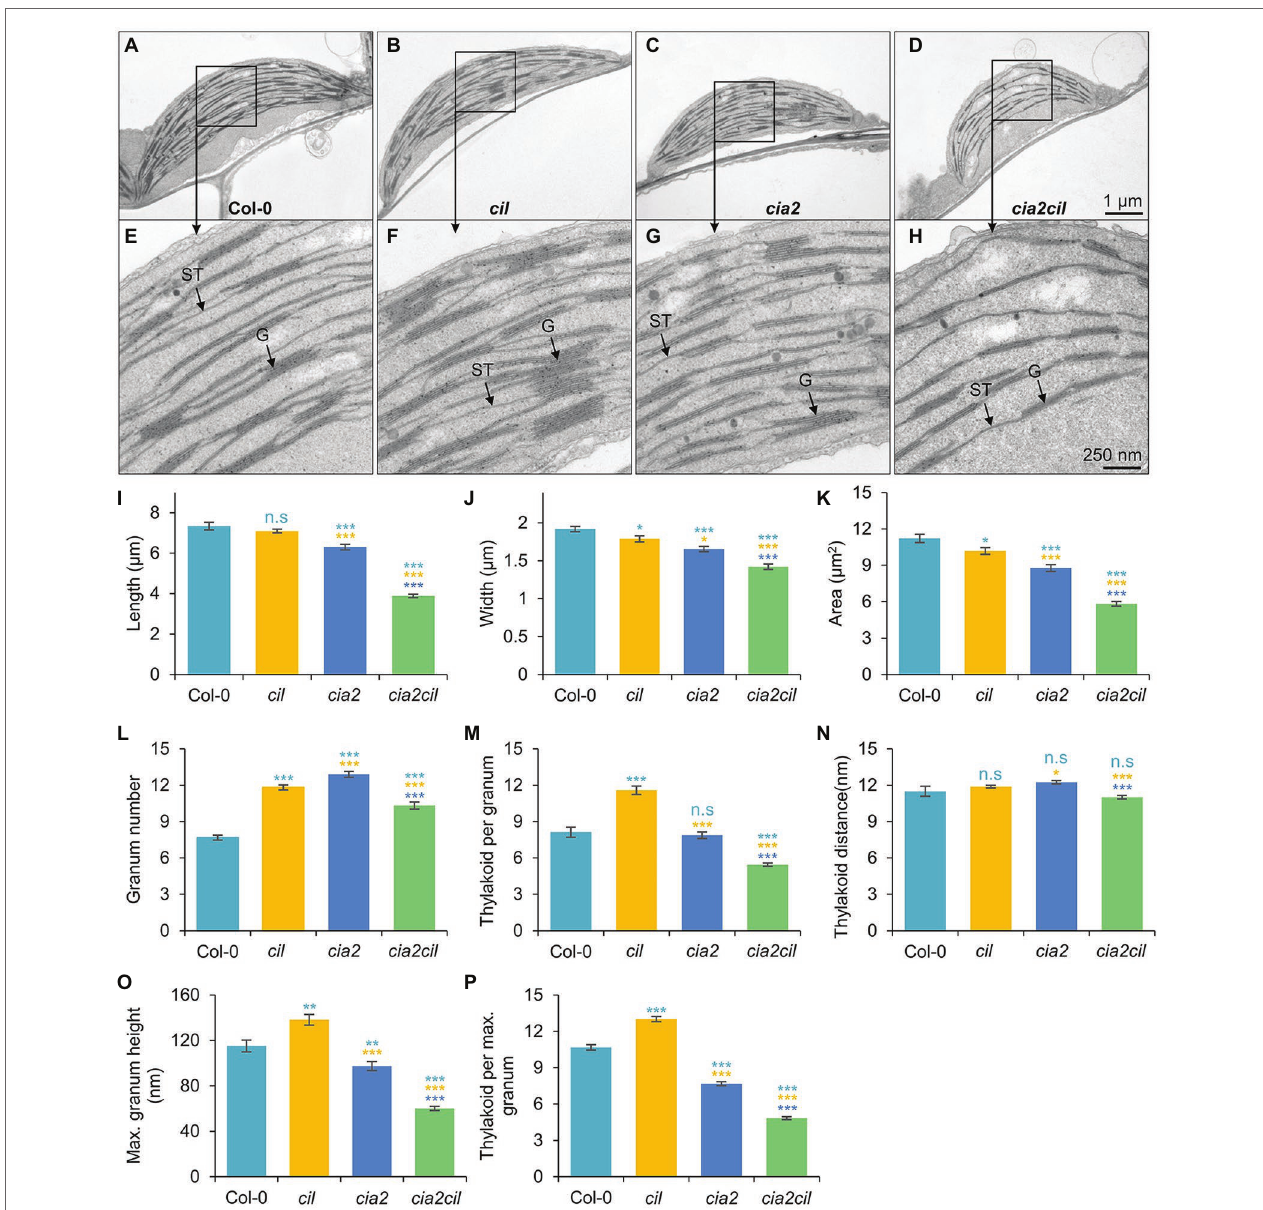
FIGURE 5 | Ultrastructural analysis of chloroplasts of the wild type Col-0, and cia2 , cil , and cia2cil mutants. (A–H) Comparison of the chloroplast ultrastructure in wild type and mutants. Panels (E–H) represent larger magnification of marked areas of the corresponding plastid in the top panels (A–D) , respectively. ST, stroma thylakoid; G, granum. (I–P) Quantification of chloroplast architecture and components of photosynthetic apparatus. The granum number (L) and thylakoid per granum (M) were counted within an area of 1 μ m 2 . Maximum granum height (O) represents the granum with maximum number of thylakoid membranes within each chloroplast. Thylakoid per maximum granum (P) represents the number of thylakoid membranes within the highest granum. Results are presented as mean ± SEM ( N ≥ 40). Student’s t-test (Tails = 2; Type = 3) significant levels, n.s, not significant; * p < 0.05; ** p < 0.01; *** p < 0.001. From top to bottom: statistical analysis of significance was performed as compared to Col-0, cil , and cia2 ,